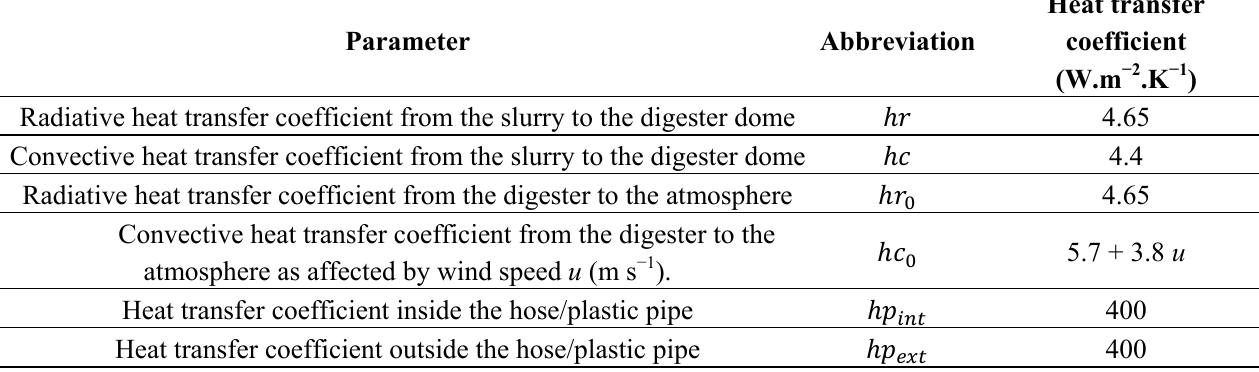
Table 1. Heat transfer coefficients used in the calculations